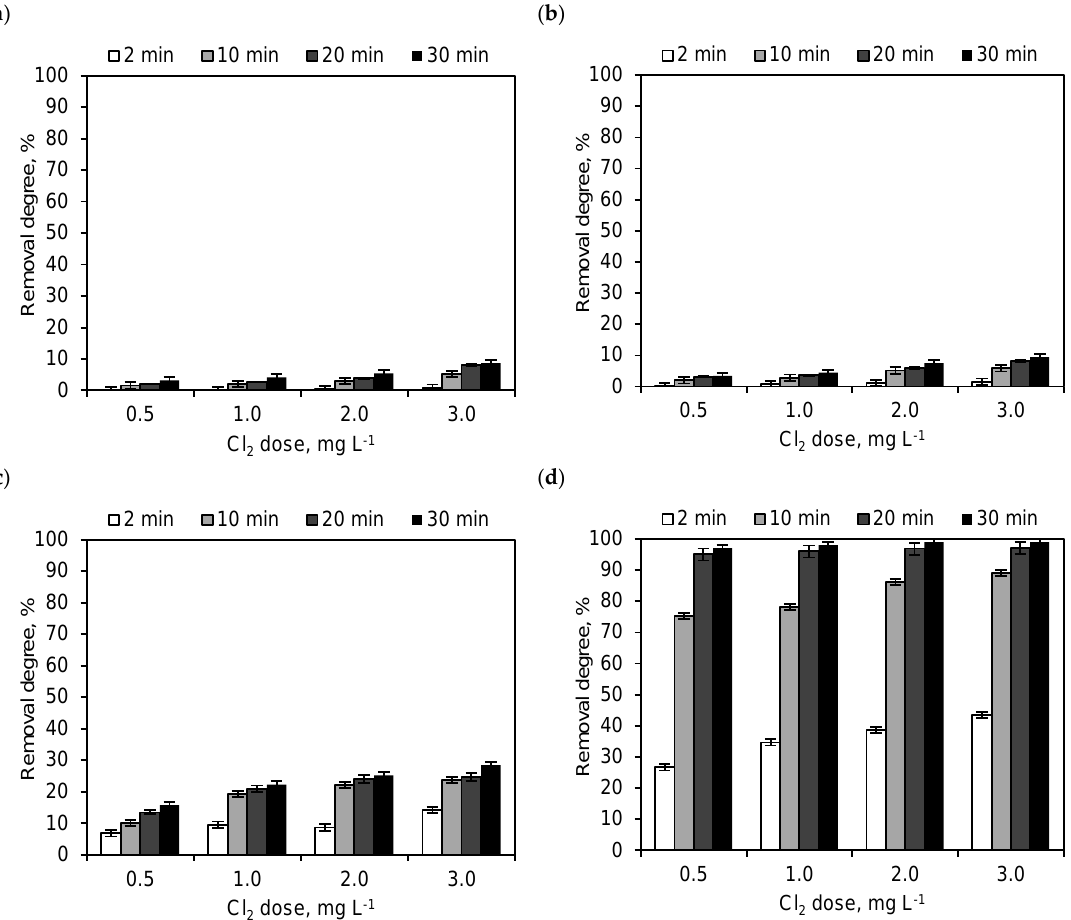
Figure 1. Change of ( a ) IBU, ( b ) BE, ( c ) ACR, and ( d ) E2 concentration during single chlorination of deionized water solutions.